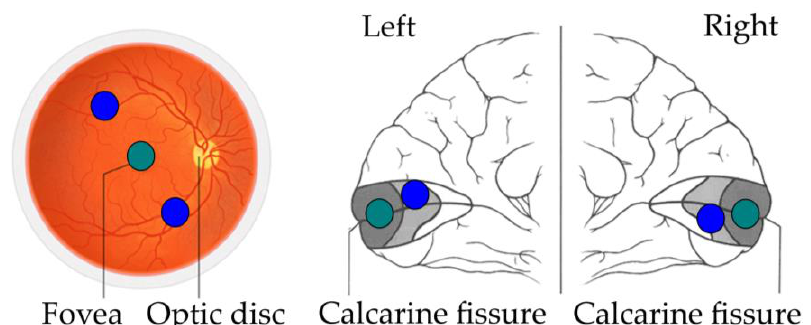
Figure 1. Peripheral information from the retina is forwarded to peripheral retinotopic cortex and foveal information is forwarded to foveal retinotopic cortex. Task relevant information is then fed back to foveal retinotopic cortex from higher cortical areas.